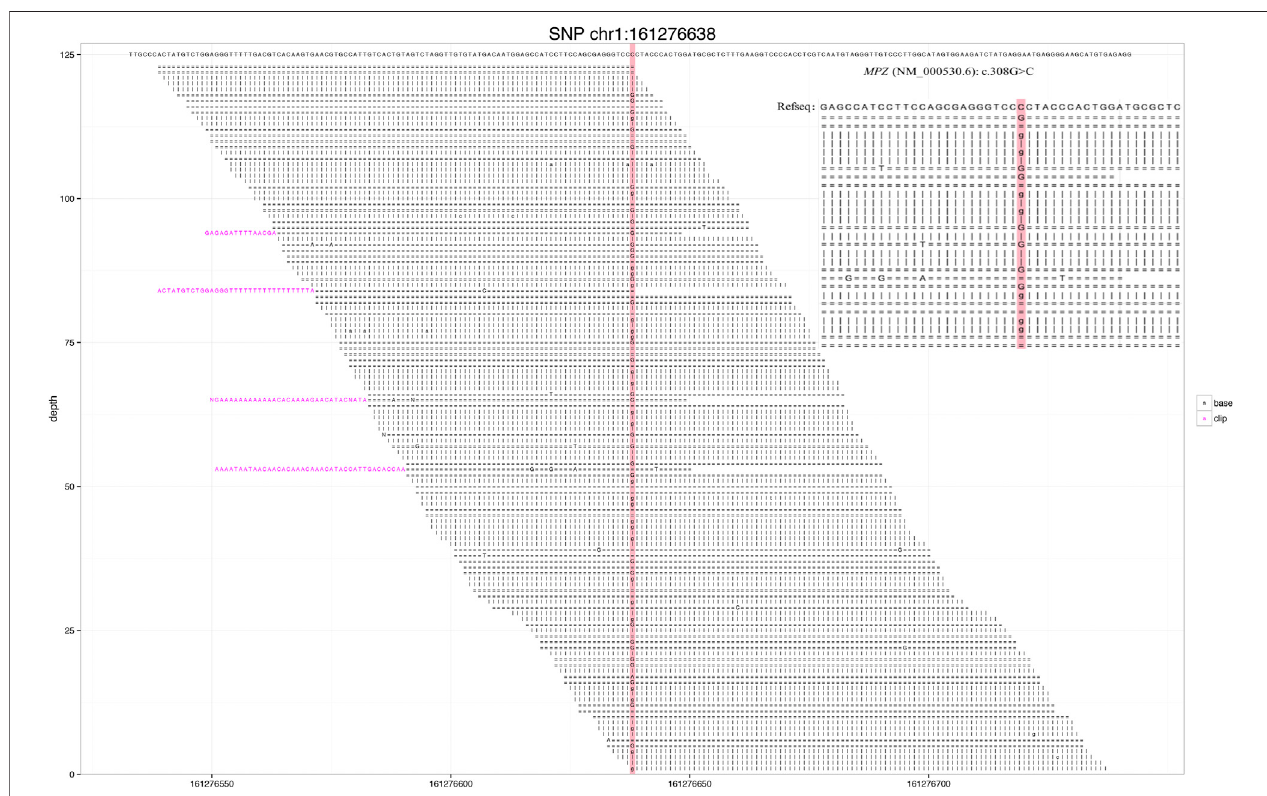
FIGURE 1 | N ext-generation sequencing revealed a small number of reads in the myelin protein zero (MPZ) gene. Red area indicates the locus with substitution mutation (c.308G > C), as supported by 171 high-quality reads.